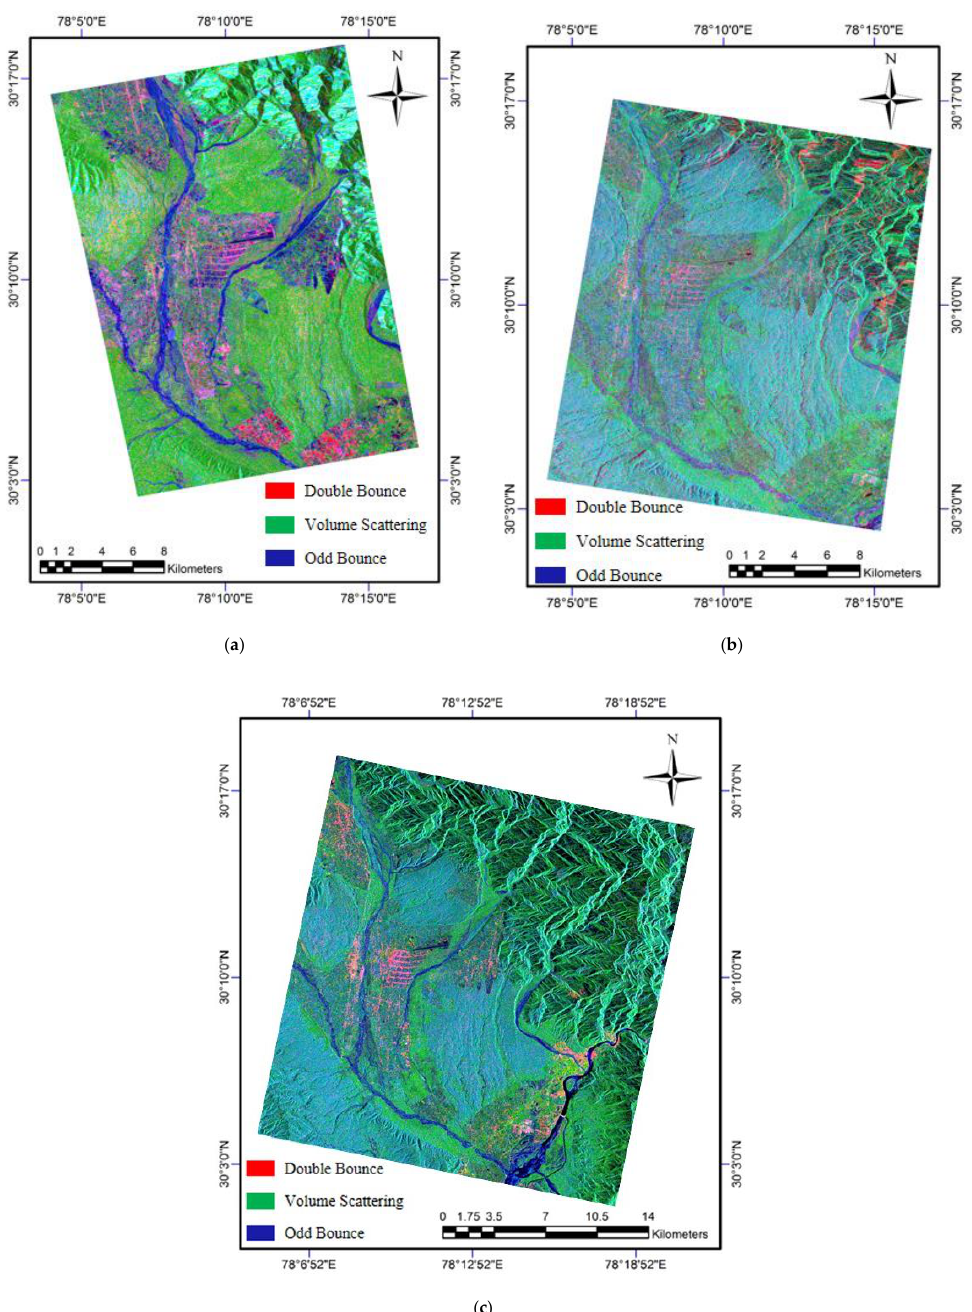
Figure 7. Polarimetric decomposition-based scattering representation of ( a ) ALOS-2 PALSAR-2 L- band, ( b ) TerraSAR-X band, and ( c ) RADARSAT-2 C-band SAR data. ( b ) TerraSAR-X band, and ( c ) RADARSAT-2 C-band SAR